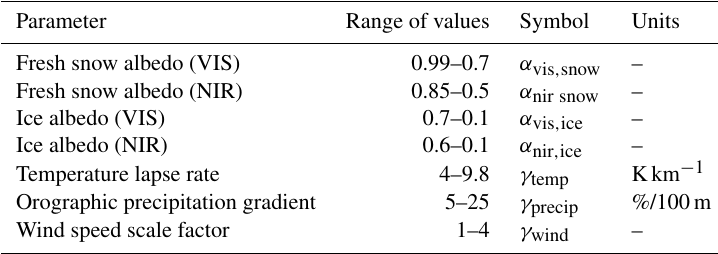
Table 1. Tuneable parameters for mass balance calculation and their ranges from the literature.